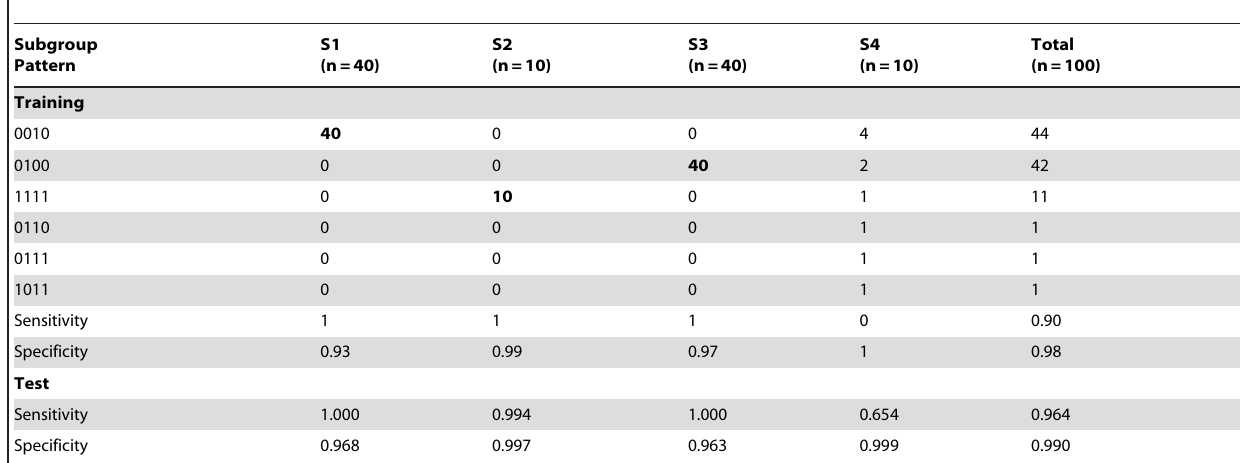
Table values are the averages over 1,000 repetitions.